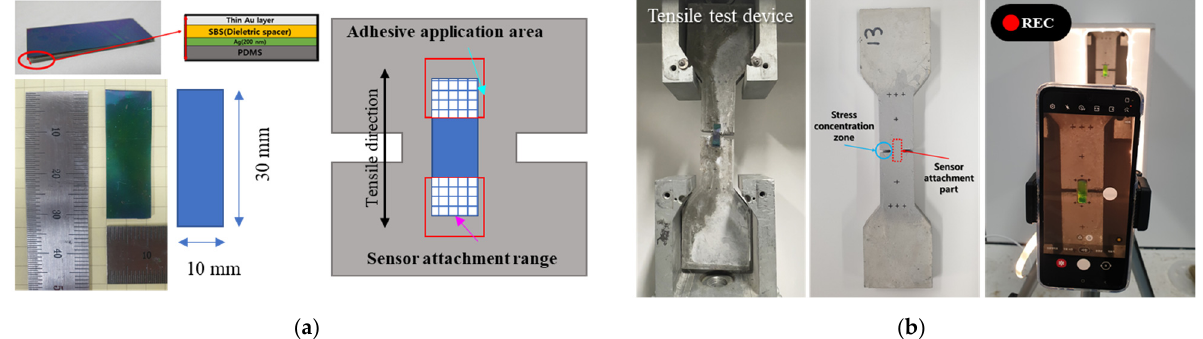
Figure 2. Contents of the test environment for measuring the deformation of the specimen and the discoloration response of the mechanochromic sensor. ( a ) Environment and method for attaching mechanochromic sensor; ( b ) stress concentration zone and setting for video recording.